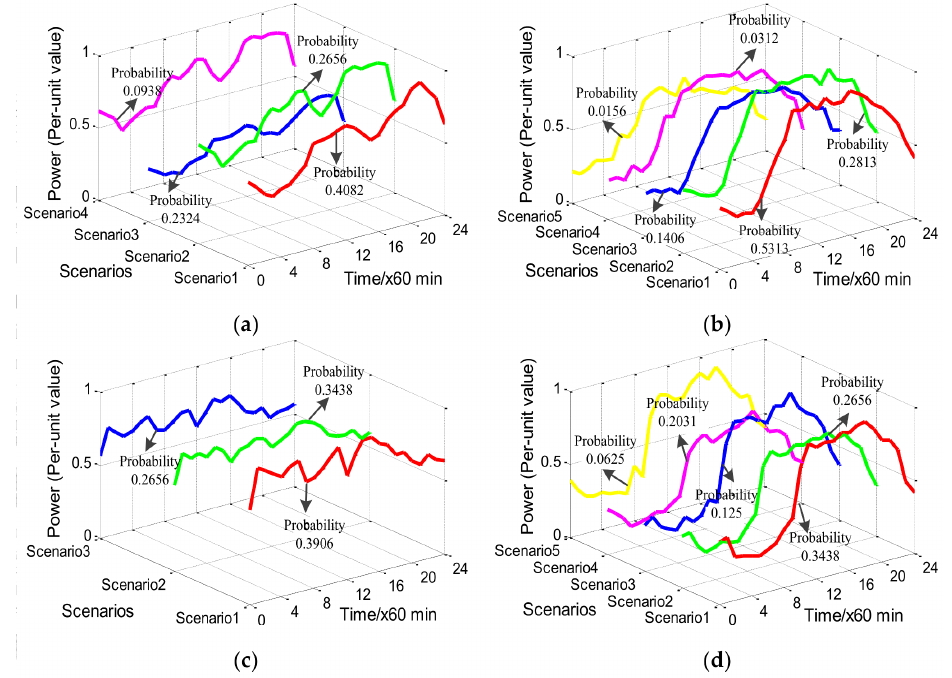
Figure 7. The timing scenarios of the winter electric load on weekdays for typical functional